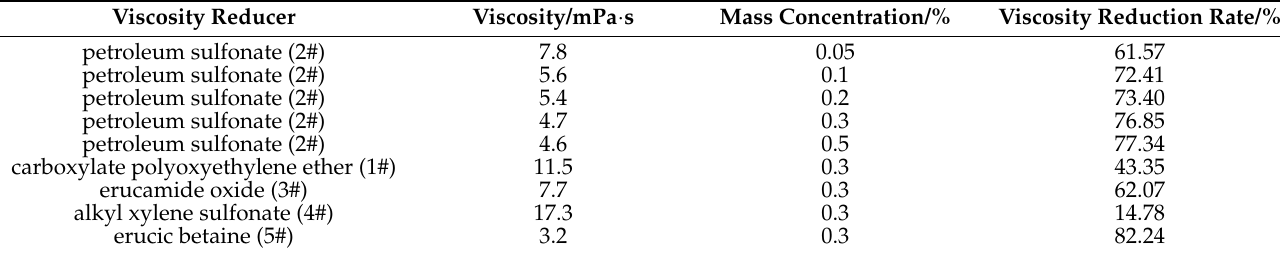
Table 1. Viscosity reduction